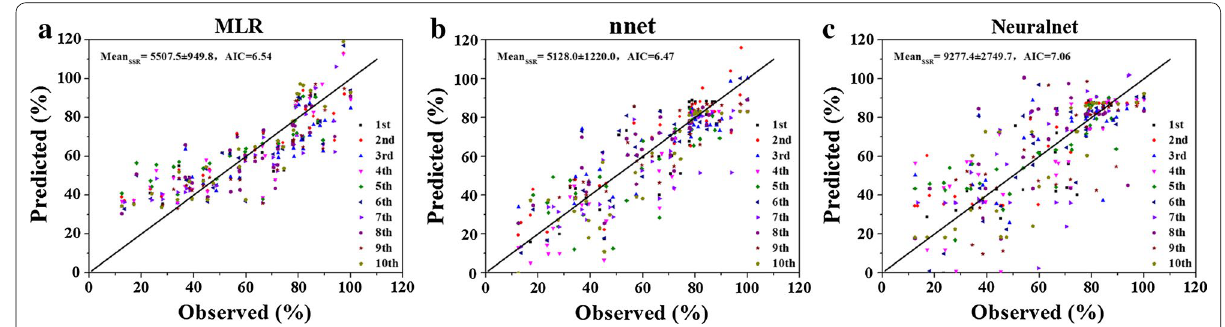
Fig. 7 Comparison of three models to predict zinc leaching efficiency. a MLR model; b nnet model; c neuralnet model. 50 random samples were used to construct the models, and then the remaining 30 samples were predicted (reshuffled 10